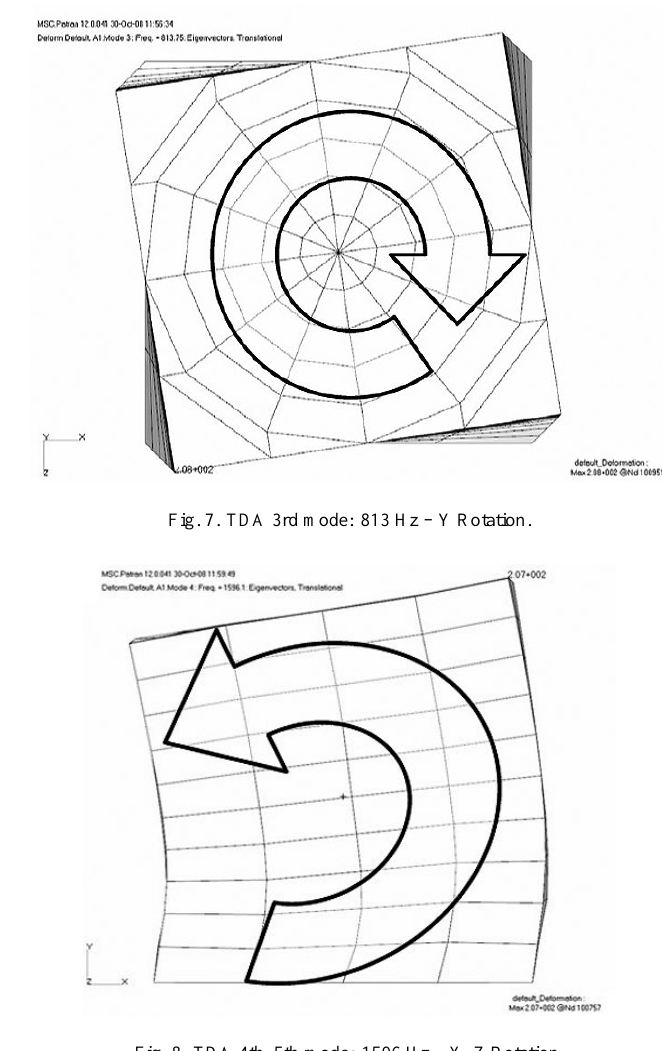
Fig. 8. TDA 4th–5th mode: 1596 Hz – X, Z